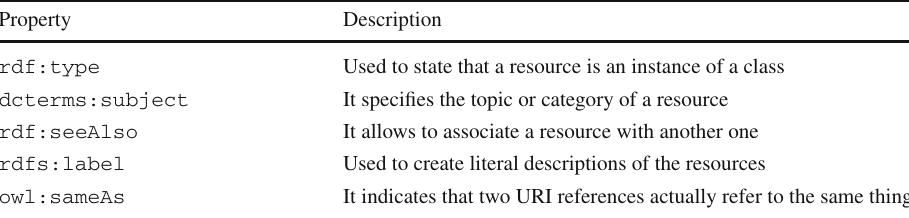
Table 4 Properties used in the enrichment process